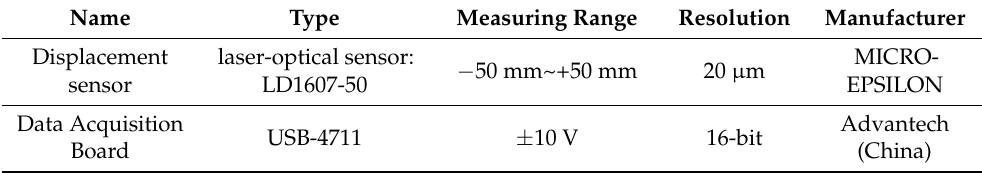
Table 2. The measuring devices technical feature.